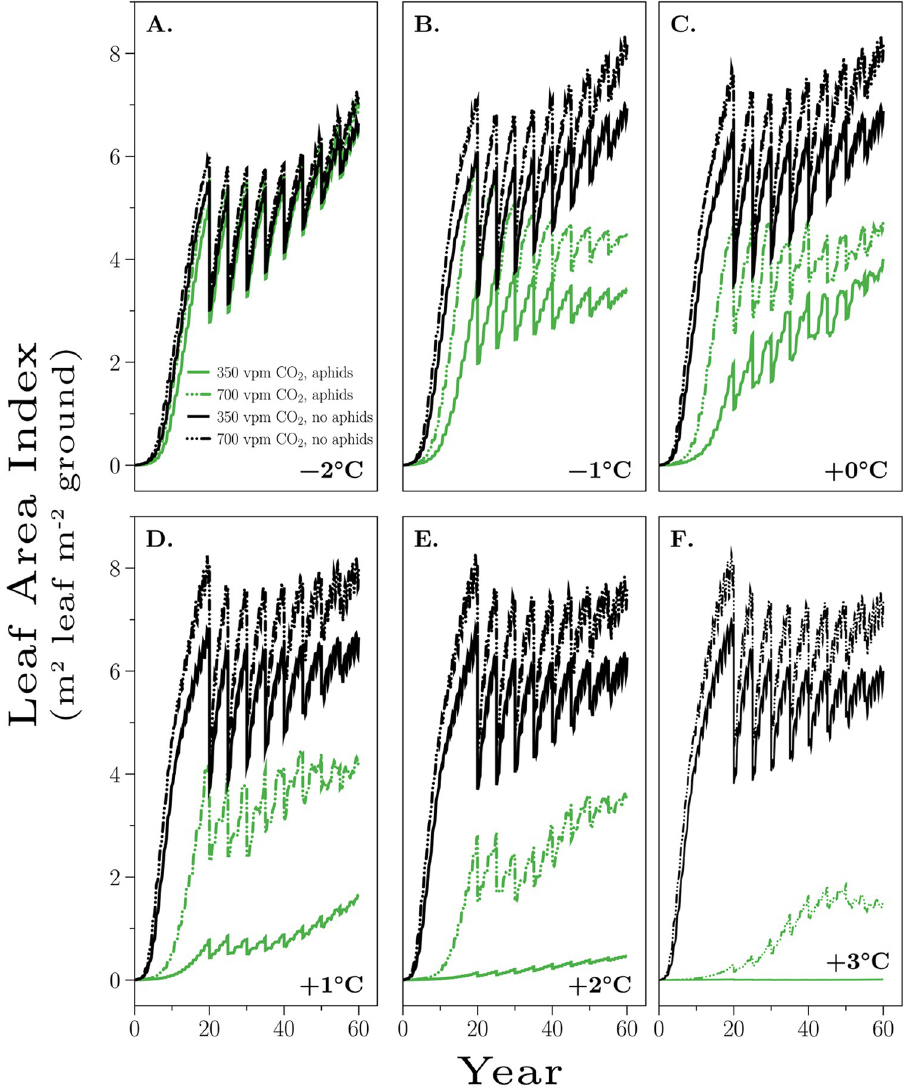
Fig 6. Leaf area indices. Shown are the Leaf Area Indices (m 2 leaf m − 2 of ground), Eq (1), for incremental temperature changes at 350 vpm and 700 vpm CO 2 , with and without aphids. The LAI values result from changes in aphid density dynamics, see Fig